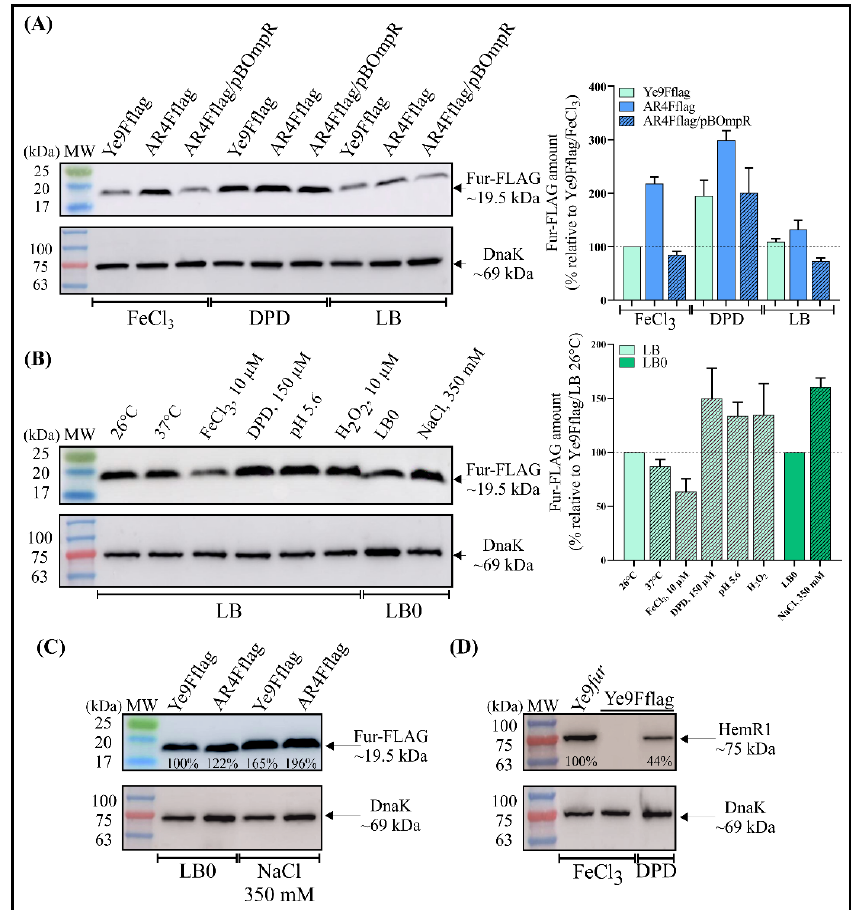
Figure 3. Western blot analysis of Fur expression in Y. enterocolitica Ye9N. ( A – C ) Levels of Fur- 3 × FLAG were analyzed in Y. enterocolitica cells grown in LB at 26 ◦ C (unless indicated) for 24 h until stationary phase. Western blotting of cell extracts was performed with a monoclonal mouse anti-FLAG epitope antibody. As a loading control, the blots were also probed with an antiserum specific for cytoplasmic molecular chaperone DnaK. The Fur-FLAG band is ~19.5 kDa in size and DnaK ~69.0 kDa. ( A , left panel) Comparison of Fur levels in the following strains: Ye9Fflag (Ye9N wild type with chromosomal fur ::3 × flag translational fusion), AR4Fflag ( ∆ ompR mutant AR4 with chromosomal fur ::3 × flag translational fusion), AR4Fflag/pBOmpR (AR4Fflag complemented with a plasmid carrying the wild-type ompR allele). The strains were grown in LB or in LB supplemented with FeCl 3 (10 µ M) or DPD (150 µ M). ( A , right panel) Quantification of the amount of Fur from three independent Western blots is shown as graphs with mean ± SEM. The amount of Fur measured in Ye9Fflag grown in LB + FeCl 3 was set to 100%. ( B , left panel) The strain Ye9Fflag was grown at a different temperature (26 vs. 37 ◦ C), iron concentration (FeCl 3 vs. DPD), reduced pH (5.6), increased oxygen stress (H 2 O 2 ) or higher osmolarity (LB0 vs. LB0 plus 350 mM NaCl). ( B , right panel) Quantification of the amount of Fur from three independent Western blots is shown as graphs with mean ± SEM. The amount of Fur measured in Ye9Fflag grown in LB at 26 ◦ C was set to 100%. ( C ) Y. enterocolitica strains differing in OmpR content were grown at 26 ◦ C in LB0 and in LB0 supplemented with 350 mM NaCl. The percentage values indicate the protein band intensities relative to Ye9Fflag grown in LB0. ( D ) Levels of HemR1